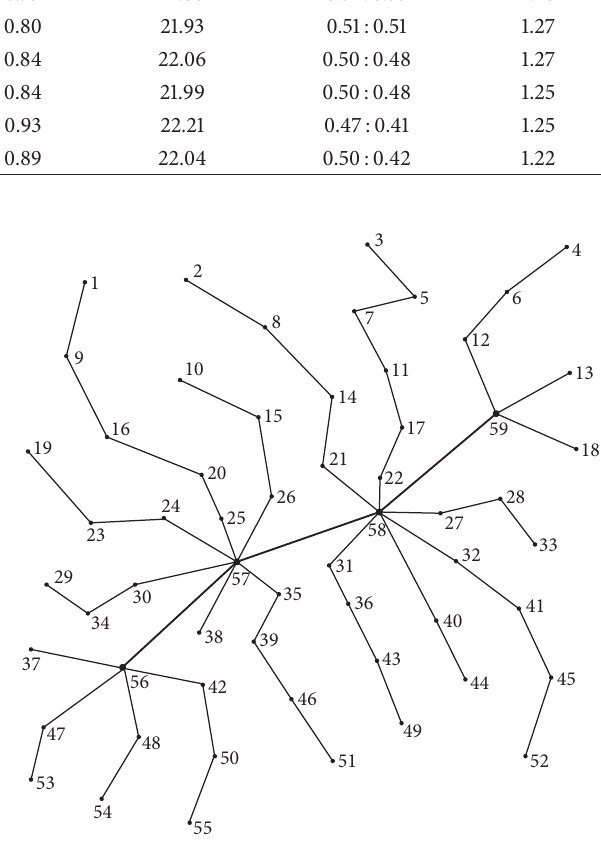
Figure 3: Optimal feeder-bus network under 𝑞 = 0